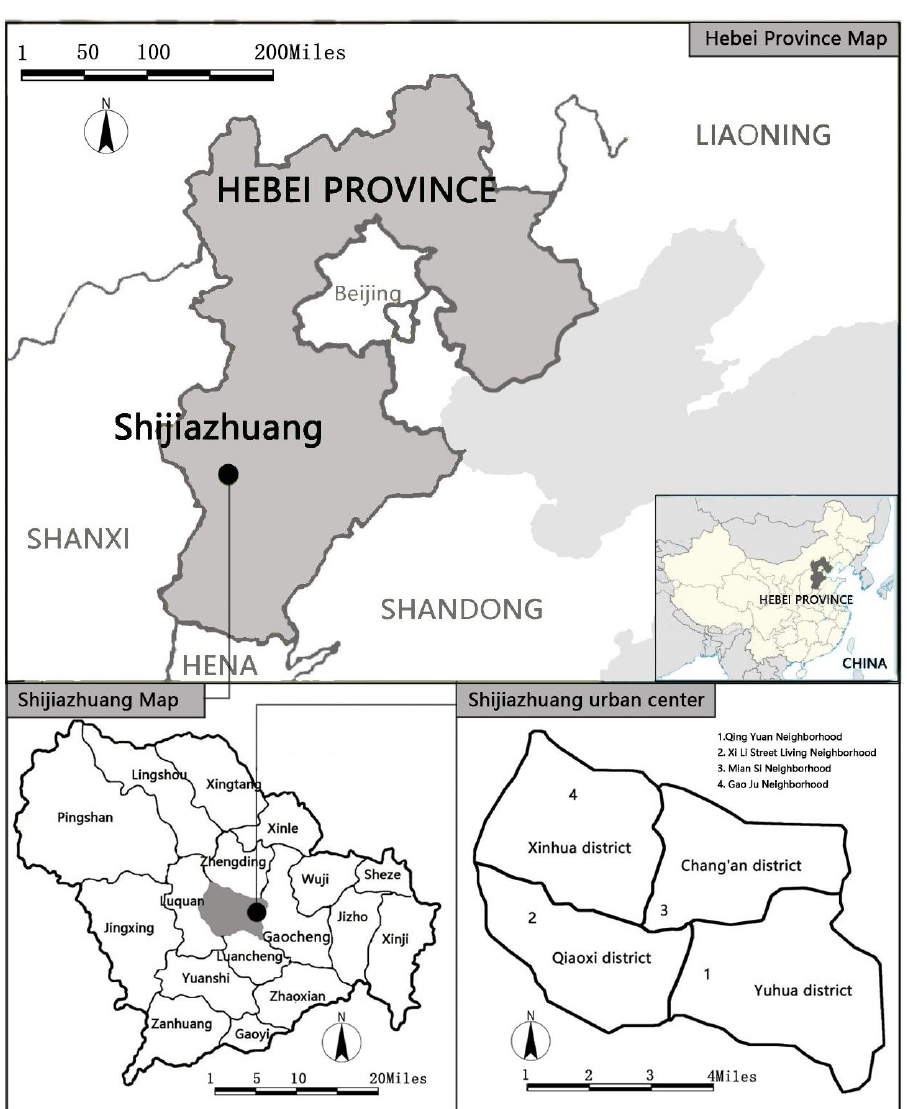
Figure 1. The location of Shijiazhuang, Hebei Province, China. Table 1. Demographic background of the respondents (N = 668).